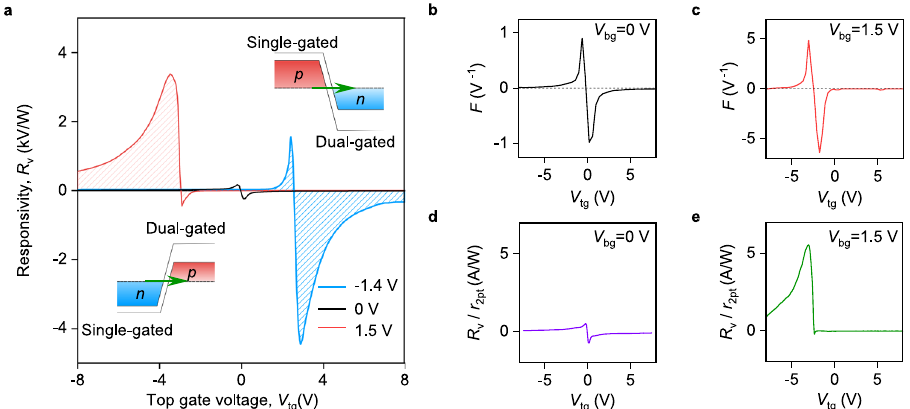
Fig. 2 Tunnelling-assisted THz detection. a Detector responsivity, R v , as a function of V tg for V bg = 0 V (black), V bg = − 1.4 V (blue) and V bg = 1.5 V (red) measured in response to f = 0.13 THz radiation. T = 10 K. Inset illustrates band pro fi les in the vicinity of the single and dual-gated interface when V bg and V tg are of opposite polarities. Green arrows illustrate interband tunnelling. b , c Normalized transconductance differentiation of the device resistance for V bg = 0 V ( b ) and V bg = 1.5 V ( c ). Note, F ( V tg ) dependencies are fairly symmetric whereas the R v ( V tg ) is highly asymmetric for the same V bg ( a ). d , e R v from a normalized to the channel resistance r 2pt as a function of V tg for given V bg